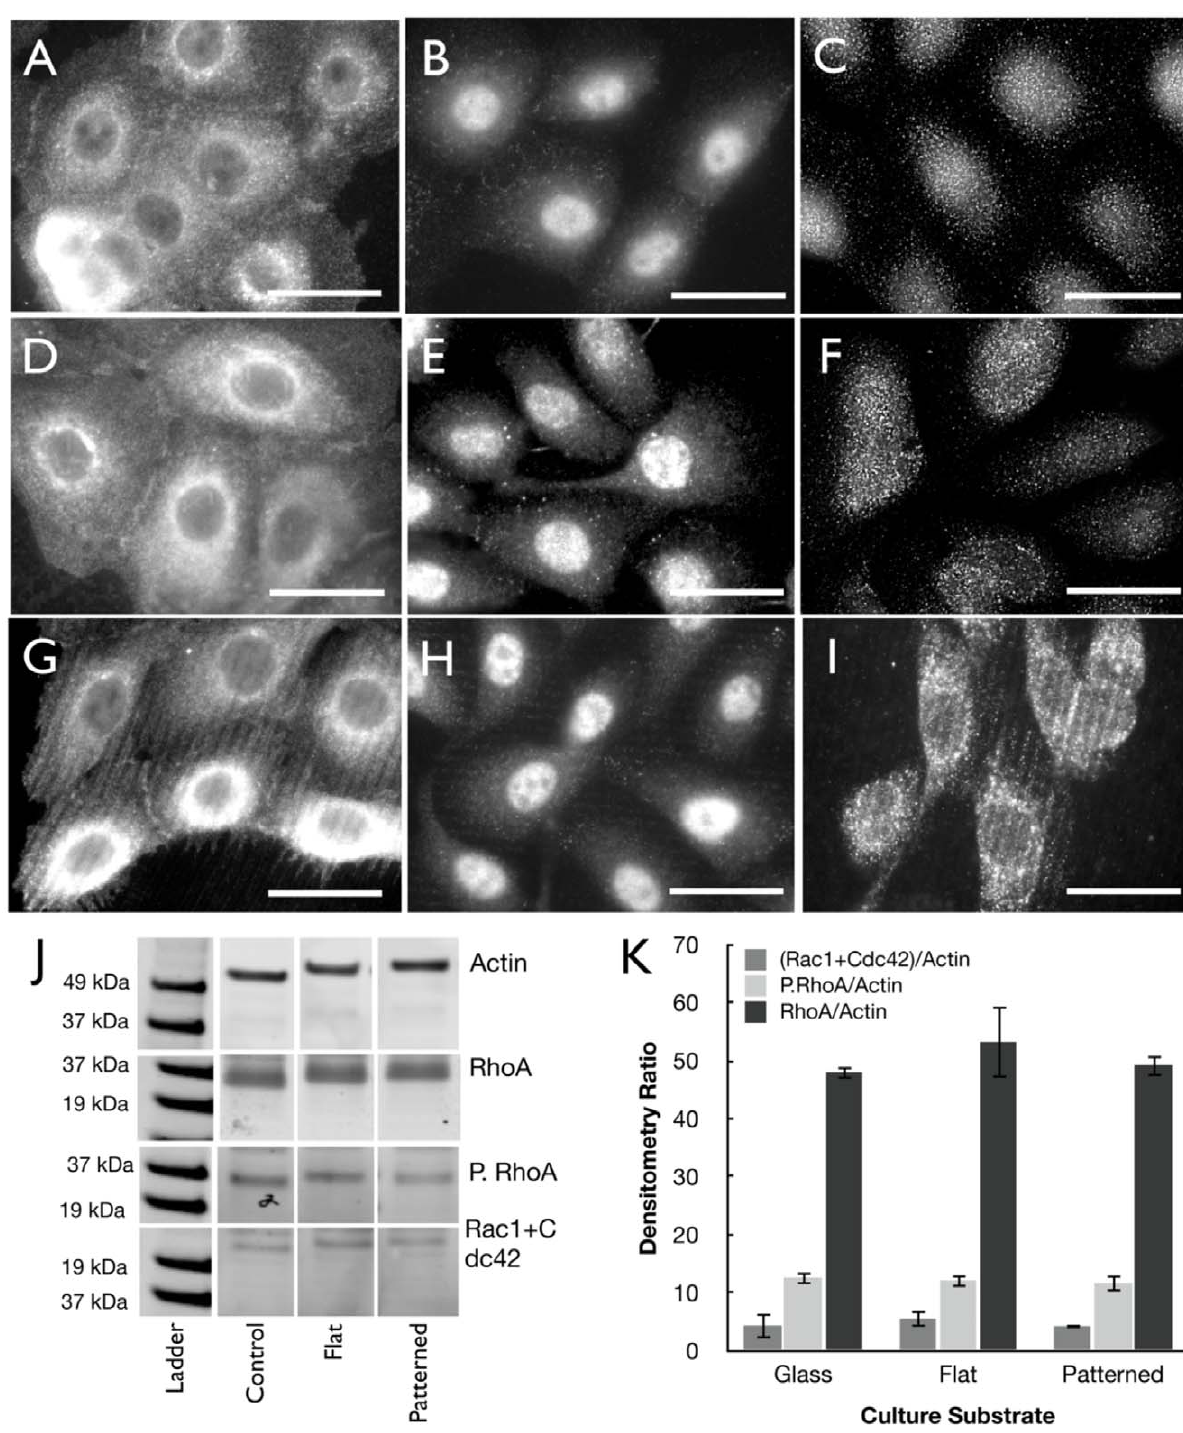
Figure 7. GTPase localization directed by silk substrate topography. Immunofluorescent imaging of RhoA, P.RhoA, and Rac1 + Cdc42 antibody binding for (A–C) glass, (D–F) flat silk, and (G–H) patterned silk surfaces respectively. (J) Western blot membrane staining and (K) densitometry results for the various GTPases (n=3, error bars=SD).